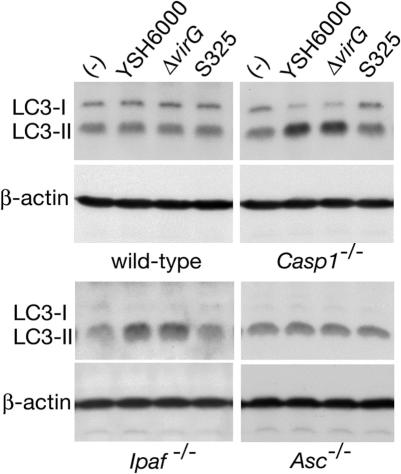
Endogenous LC3-I to LC3-II Conversion in BMMs Infected by Shigella
Wild-type, caspase-1-deficient, Ipaf-deficient, or ASC-deficient BMMs were infected with Shigella WT, ΔvirG, or TTSS mutant S325. At 30 min after infection, the total lysates of BMMs were prepared and analyzed by western blotting using anti-LC3 antibody. The immunoblot for β-actin was indicated as an internal control.